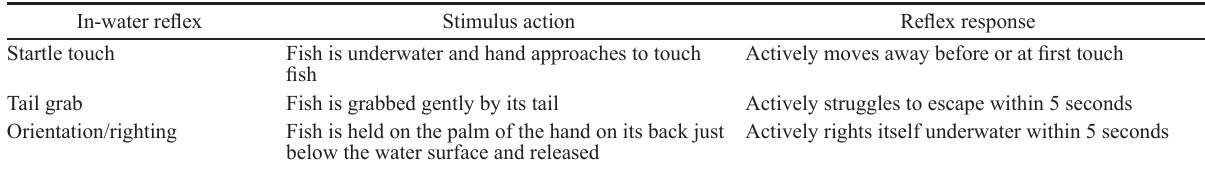
Table 3. – Reflex responses tested in water, with a description of the implemented stimuli and expected responses if the reflex was present (adapted from Catchpole et al. 2015 and Davis